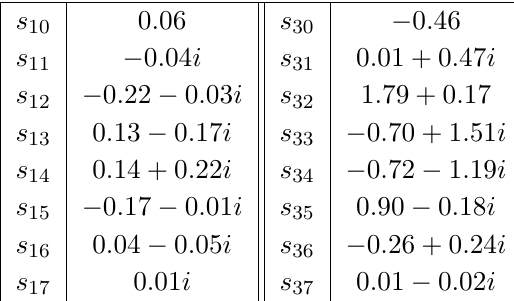
Table 3 . The fitting parameters at T = 0 . 153 GeV.